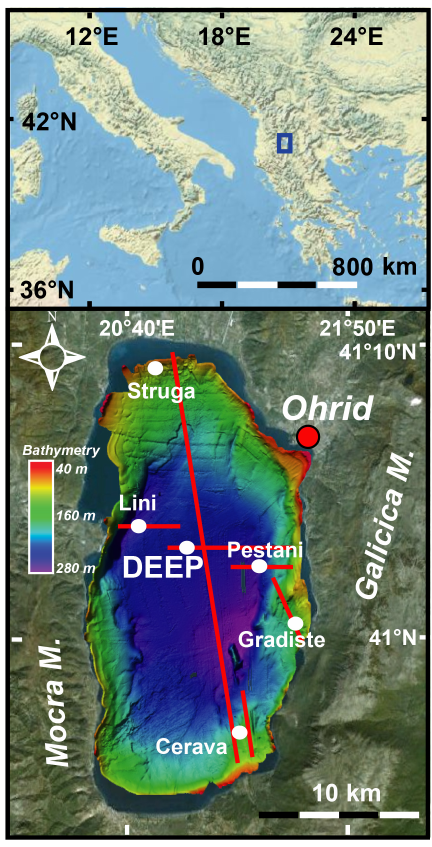
Figure 1. Topographic and bathymetric map of Lake Ohrid on the Balkan Peninsula. ICDP coring sites are indicated by white dots. The red lines indicate the locations of seismic profiles shown in Figs. 2, 3 and